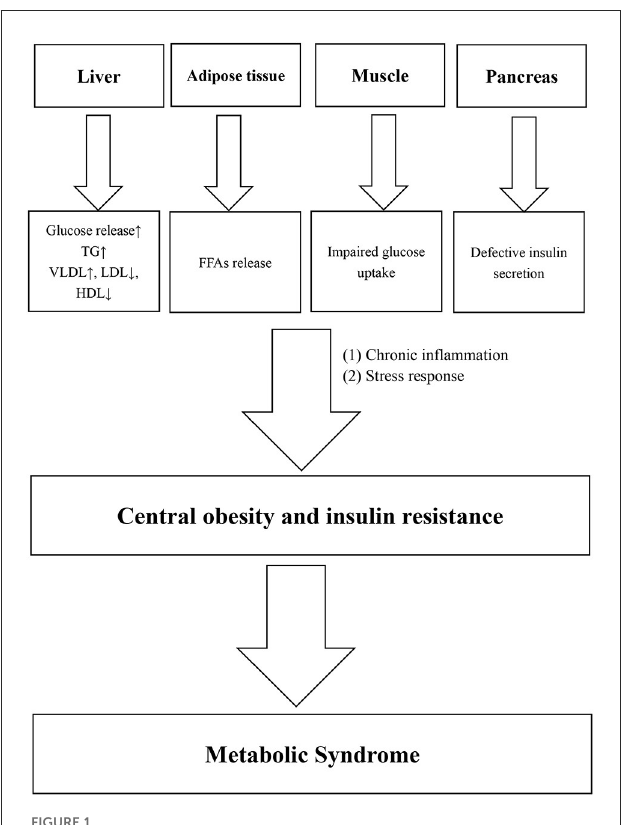
FIGURE1 Pathophysiological changes of metabolic